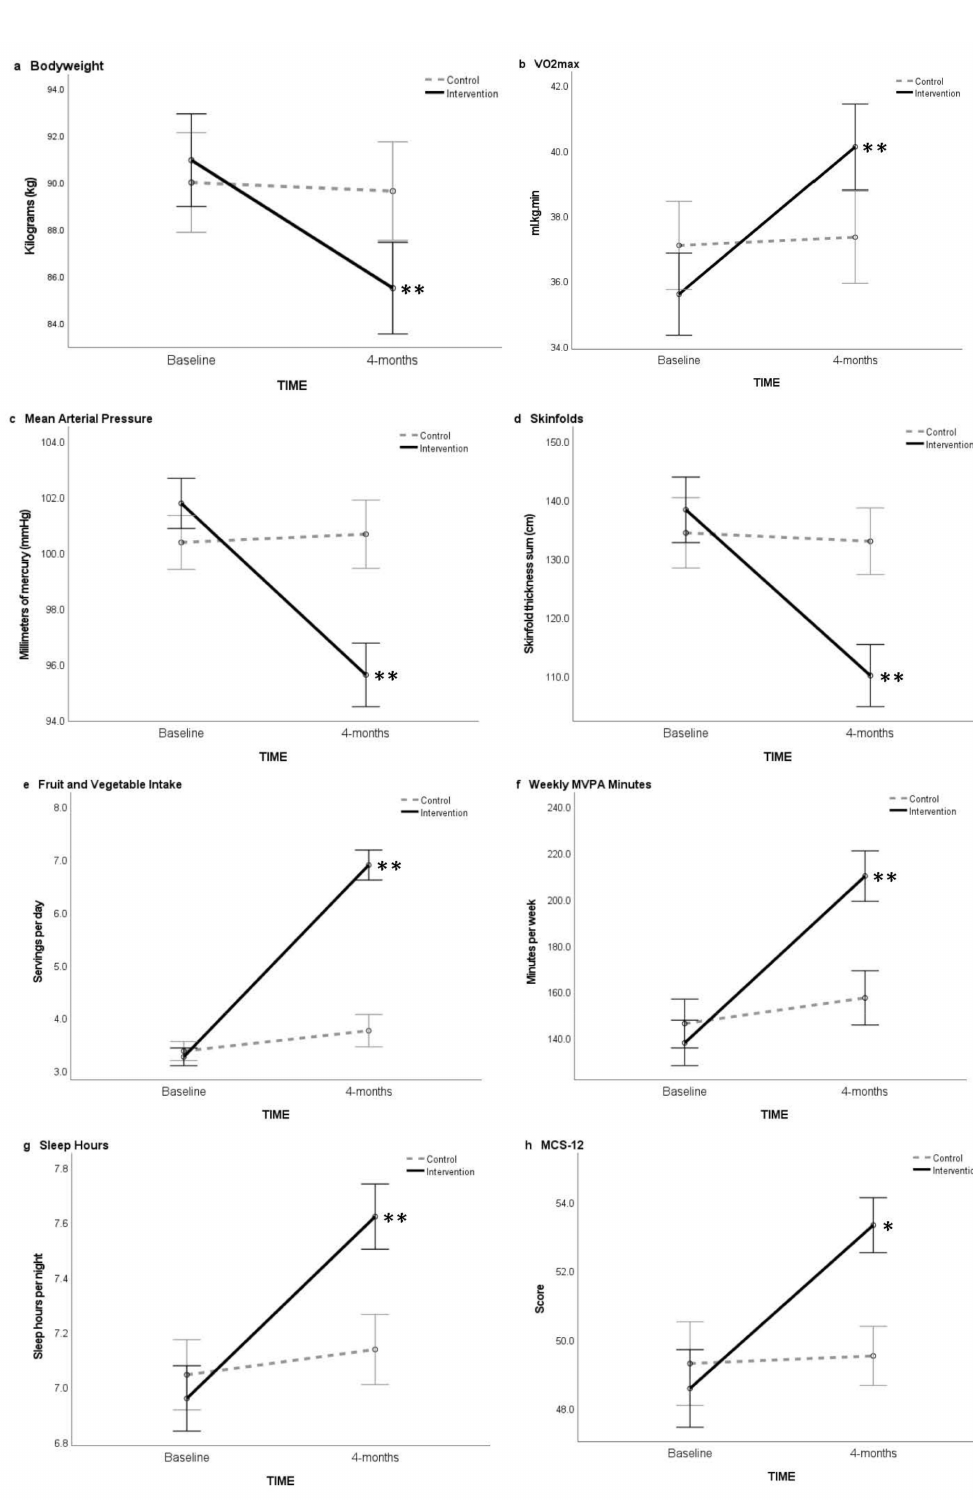
Figure 2. Mean values for health outcomes across time (baseline and 4-months), showing 95% confidence intervals (( a ), bodyweight; ( b ), VO 2max ; ( c ), Mean Arterial Pressure; ( d ), Skinfolds; ( e ), Fruit and Vegetable Intake; ( f ), Weekly MVPA Minutes; ( g ), Sleep Hours; ( h ), MCS-12). Abbreviations: VO 2max = maximal oxygen consumption; MVPA = moderate-to-vigorous physical activity; MCS-12 = Short Health Form 12v2 mental component summary score. Notes: * indicates moderate within group effect size from baseline to 4-months. ** indicates large within group effect size from baseline to